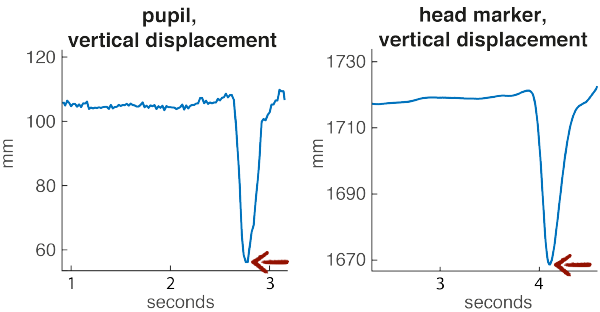
Figure 3. Vertical displacement of pupil and (front left) head marker during the nod (indicated by the red